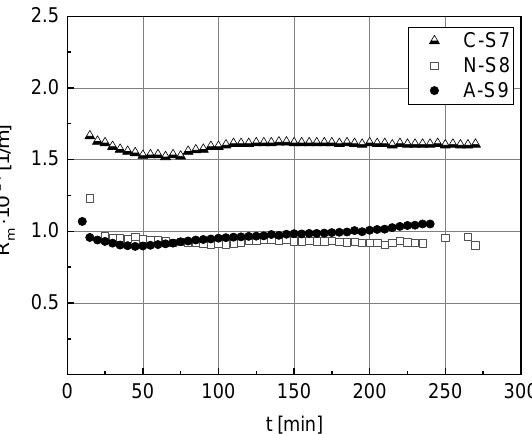
Figure 5. Hydraulic resistance of the TFC-SR3 membrane during nanofiltration of selected MTWs.